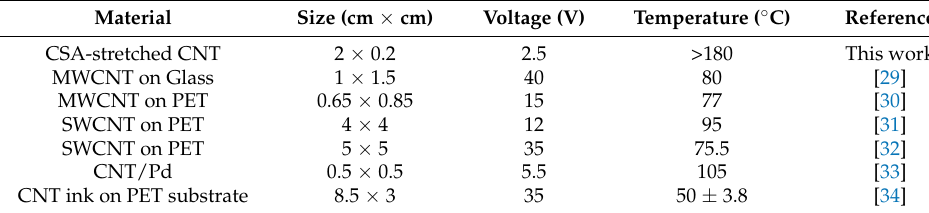
Table 1. Heating performance of carbon nanotube-based